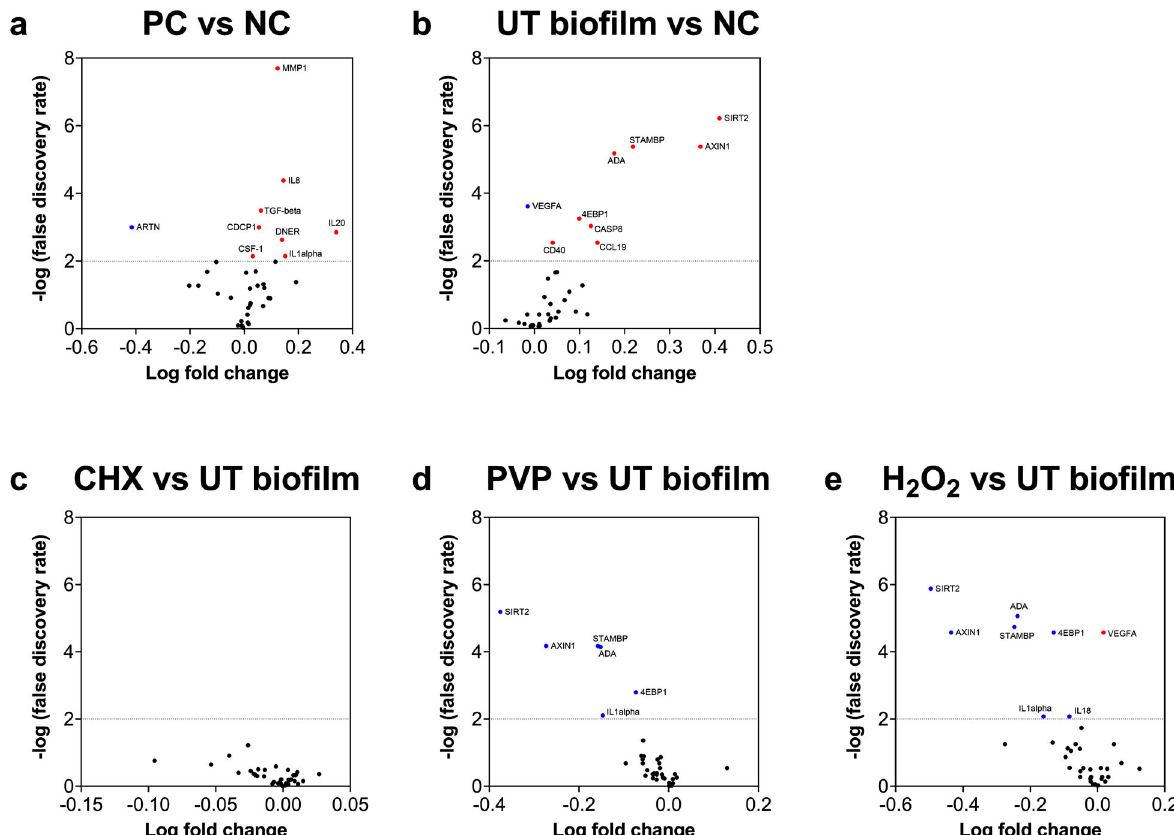
Fig. 6 Volcano plot showing signi fi cantly down- or up- regulated proteins in RHE tissue when comparing treatment modalities with controls. Volcano plots show the log fold change in protein concentration after correction of the p values using Benjamini – Hochberg false discovery rate (FDR) of 5%. Proteins that are signi fi cantly downregulated are shown in blue, and those upregulated are red. The dotted line depicts signi fi cance value of p < 0.01 (-log 2.0). PMA-stimulated positive controls (PC) were fi rst compared with unstimulated control tissue (NC) ( a ), then tissue stimulated with untreated bio fi lms with negative controls ( b ). Each treatment modality was then compared with untreated bio fi lms (CHX vs UT, panel c ; PVP-I vs UT, panel d and H 2 O 2 vs UT, panel e